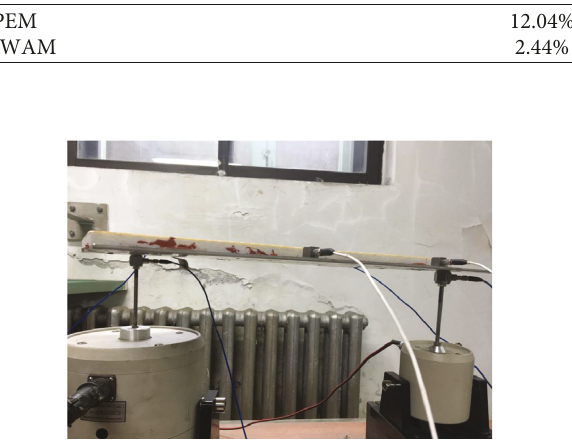
Figure 6: Photo of thermal protection composite plate experiment